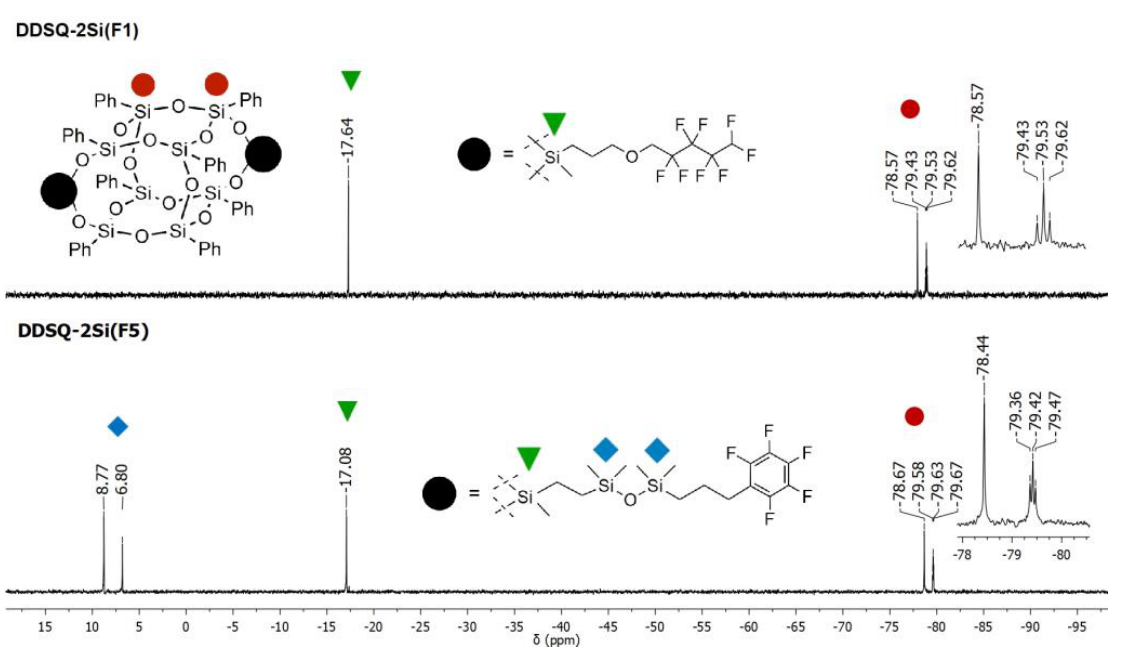
Figure 1. Selected range of stacked 29 Si NMR spectra of DDSQ-2Si(F1) and DDSQ-2Si(F5) .